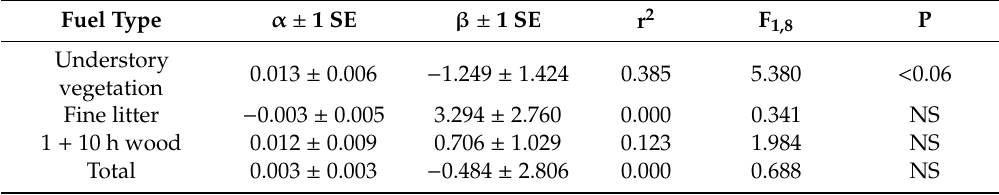
Table A4. Linear models of maximum ∆ turbulent kinetic energy and consumption of surface and understory fuels during the eight prescribed burns. Data were fit to the equation y = α × (variable) + β . NS = not significant.